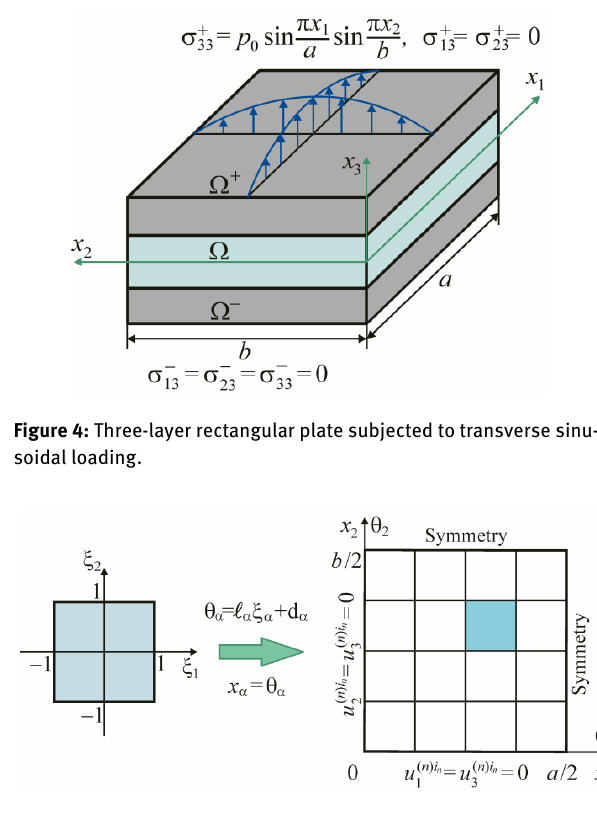
Figure 5: One quarter of the three-layer rectangular plate discretized by uniform 4 n × 4 n meshes, where the mesh parameter n = 1,2, . . . 16 .